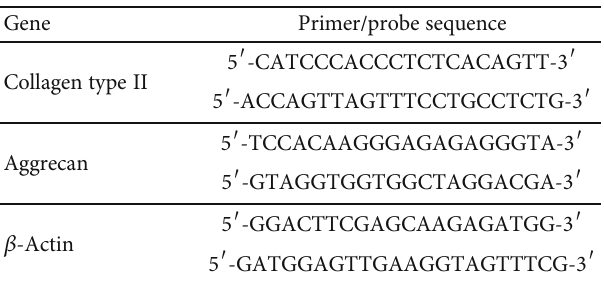
Table 1: Primers used for reverse transcription quantitative polymerase chain